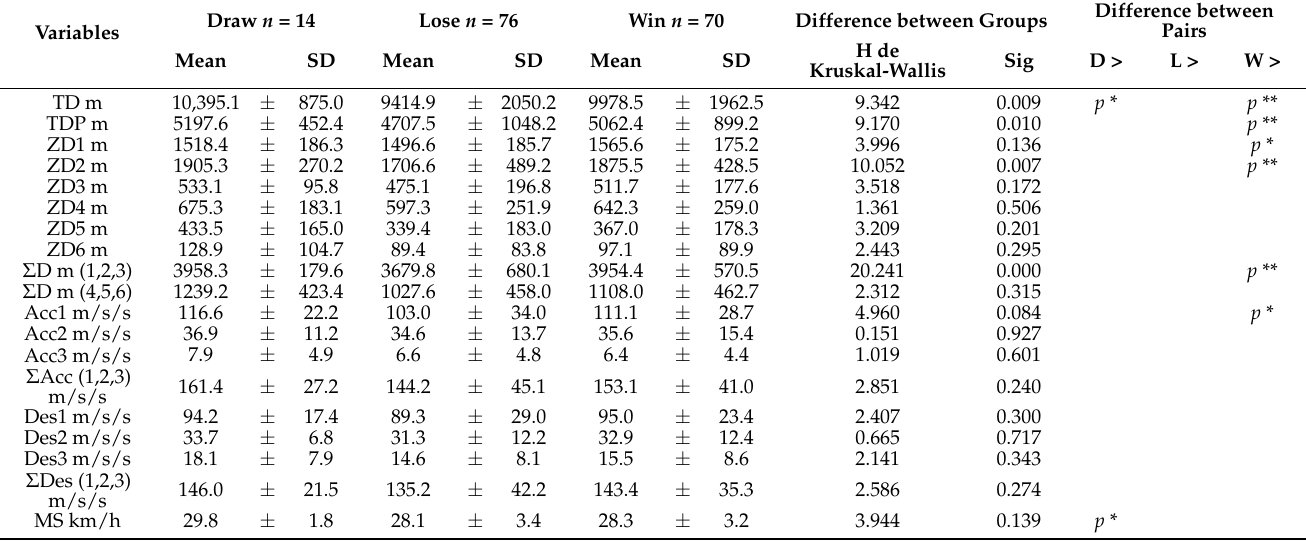
Table 4. Distances covered across each speed threshold when the teams drew, lost, or won (Data reported as mean ± SD).